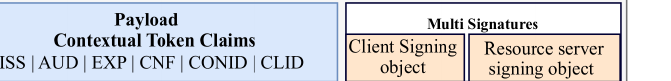
Figure 6. Proposed contextual access token, with conid: hash of the context identifier, clid: hash of the client identifier .